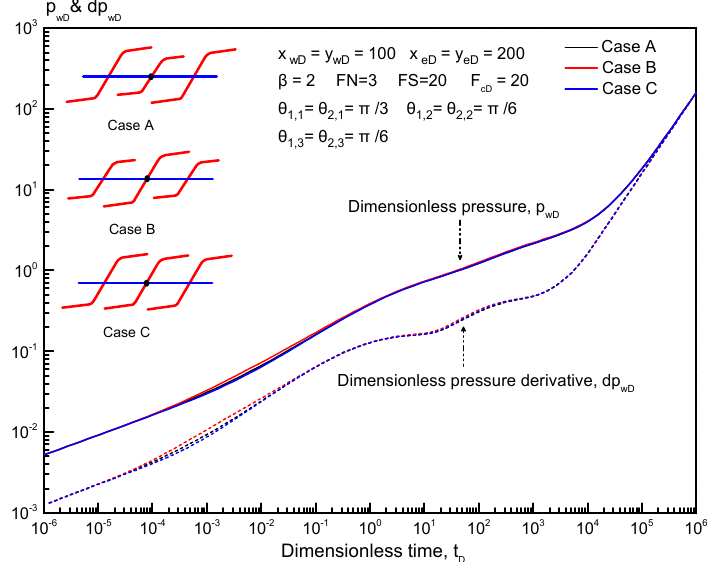
Figure 20. E ff ect of complex fracture configuration under di ff erent fracture distributions on pressure Figure 20. Effect of complex fracture configuration under different fracture distributions on pressure and pressure derivative (FN = and pressure derivative (FN = 3).